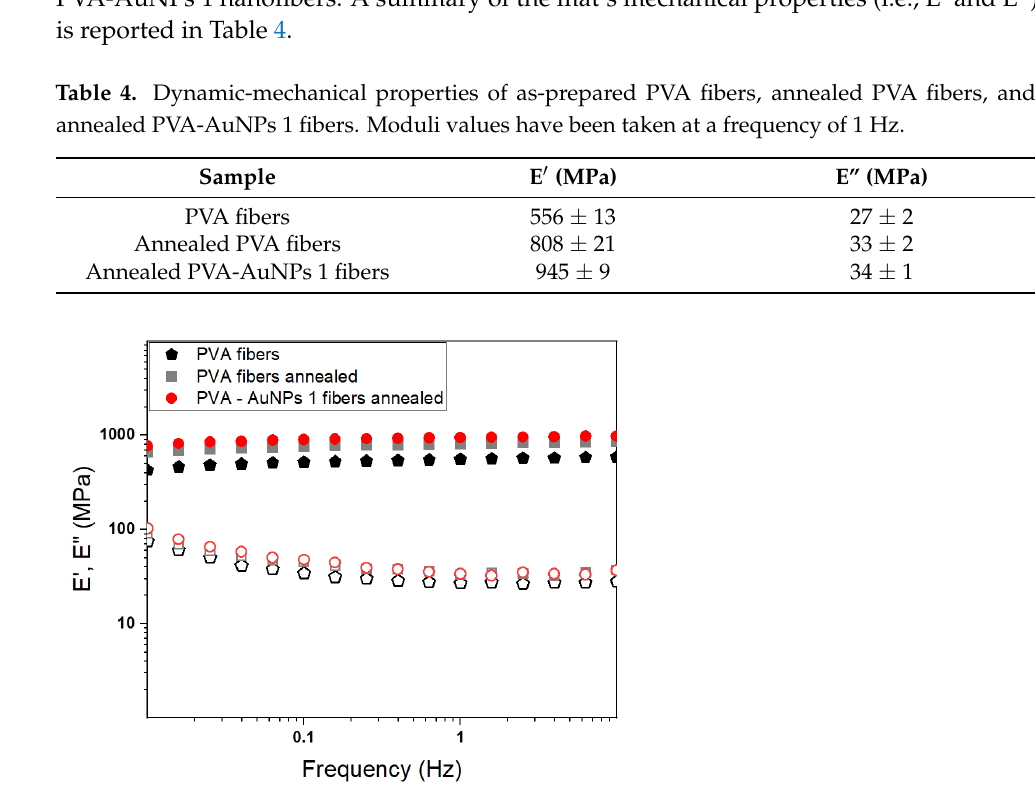
Figure 7. DMA spectrum of as-prepared PVA fibers, annealed PVA fibers, and annealed PVA- AuNPs 1 fibers. Filled and empty symbols represent the extensional storage and extensional loss moduli, respectively. Table 4. Dynamic-mechanical properties of as-prepared PVA fibers, annealed PVA fibers, and annealed PVA-AuNPs 1 fibers. Moduli values have been taken at a frequency of 1 Hz.